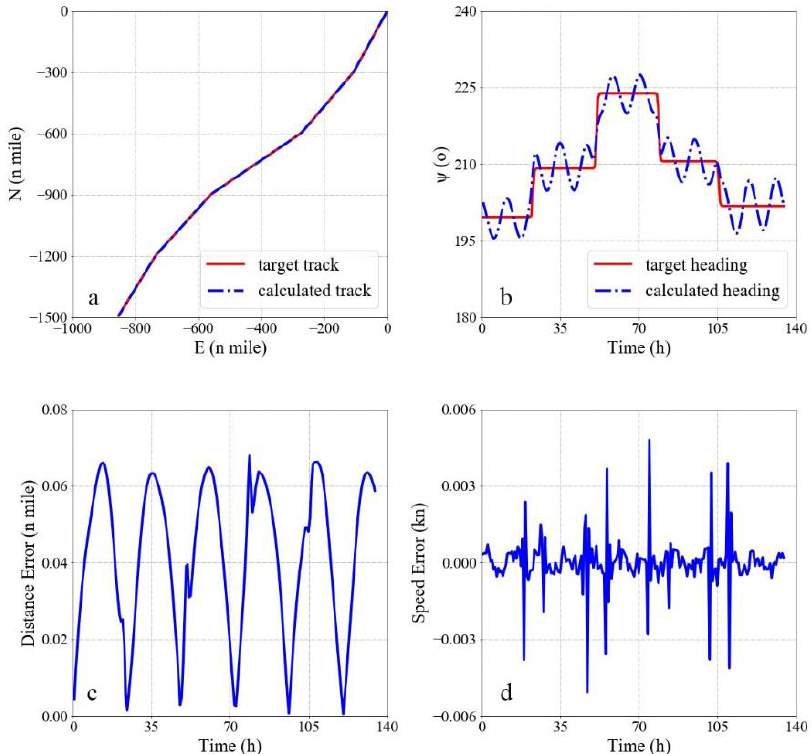
Figure 4. Results of sailing under the effects of the wind, waves and currents. ( a ) Comparison of the track, ( b ) comparison of heading, ( c ) distance error, and ( d ) speed error.